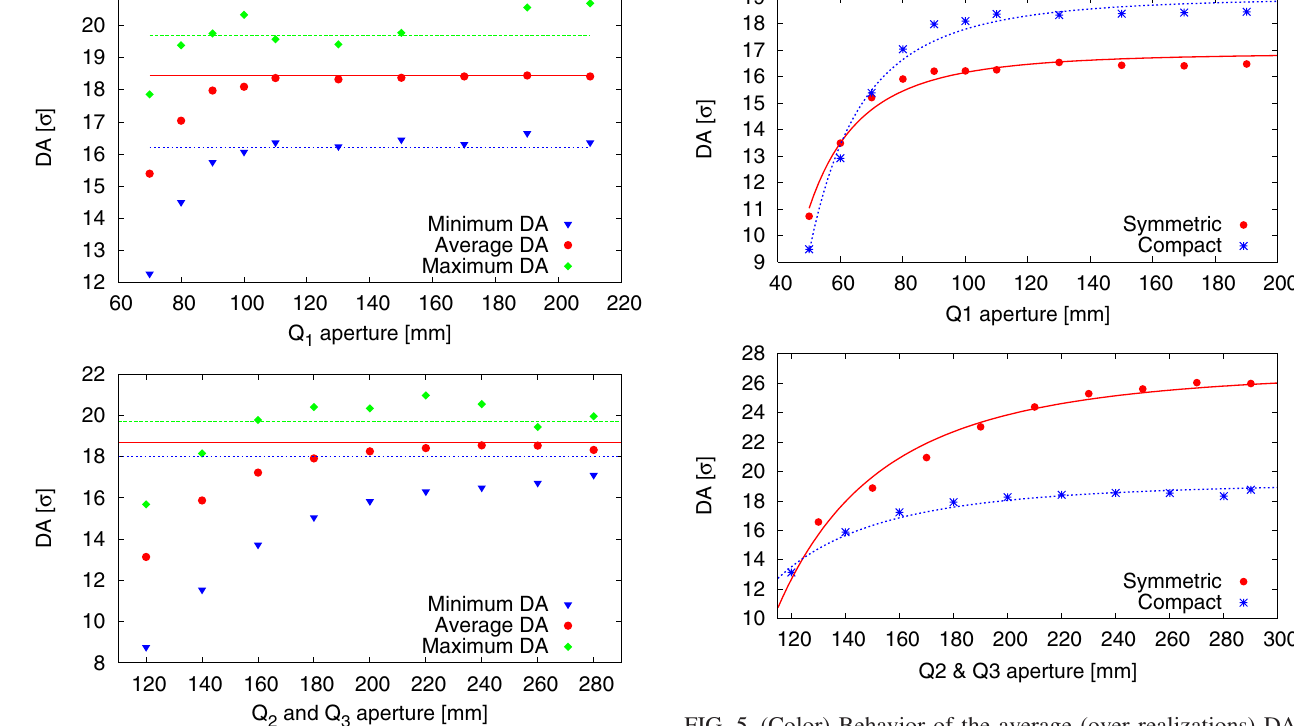
FIG. 5. (Color) Behavior of the average (over realizations) DA as a function of quadrupole apertures: (top) Q 1 and (bottom) Q 2 and Q 3 . A fit of the function f ð (cid:5) Þ ¼ a(cid:5) (cid:1) 3 þ b is shown for all cases.